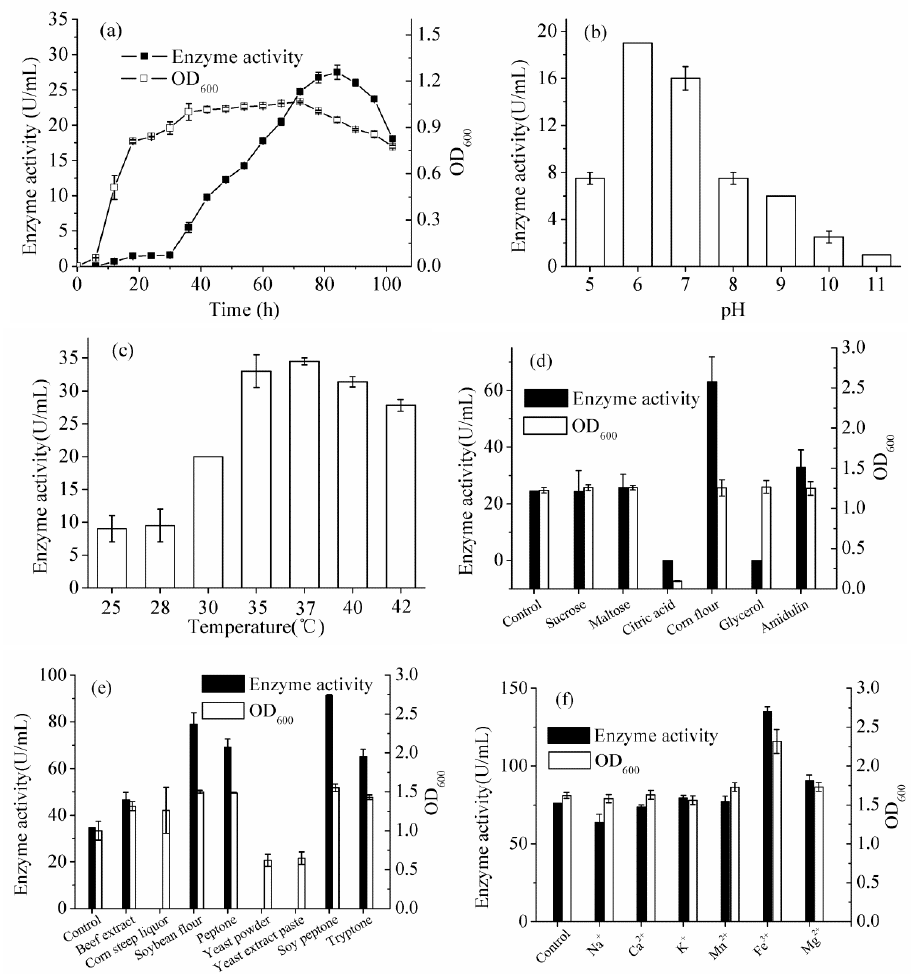
Figure 3. The fermentation experiments. ( a ) The fermentation curve of cell growth and enzyme activity, OD means optical density; ( b ) Effect of initial pH values on trypsin activity; ( c ) Effect of culture temperatures on trypsin activity; ( d ) Effect of carbon sources on trypsin activity and cell growth; ( e ) Effect of nitrogen sources on trypsin activity and cell growth; ( f ) Effect of metal ions on trypsin activity and cell growth.